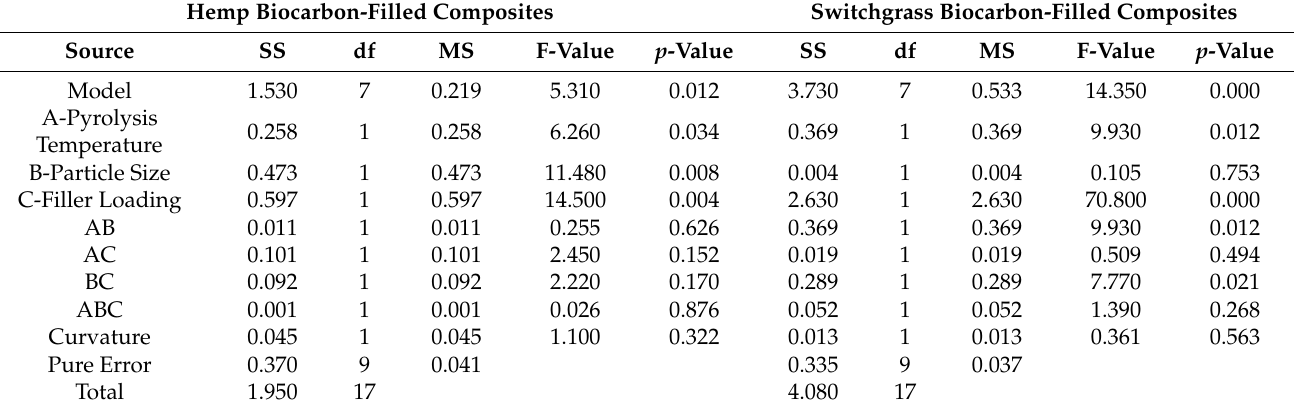
Table 2. Full-Model ANOVA Table for the Water Absorptivity as Response of the Biocarbon-Filled Hemp-Reinforced Polymer